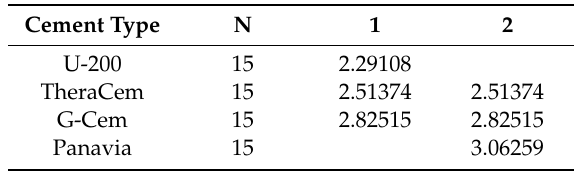
Table 3. The post hoc Tukey test for multiple comparisons for samples that underwent 6 months of aging *.